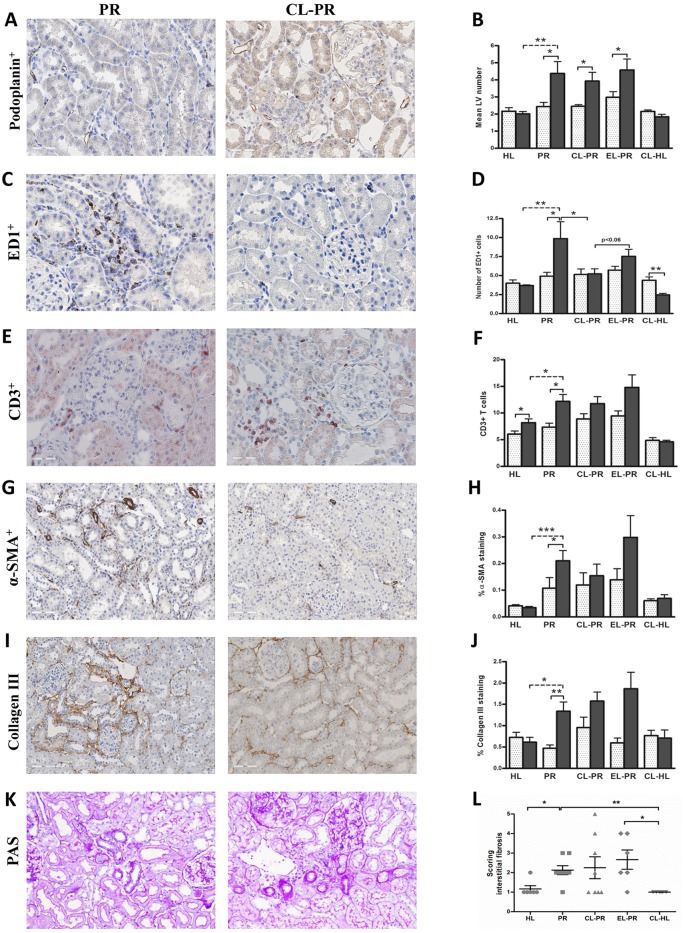
Effects of macrophages depletion by CLs on renal lymphangiogenesis, inflammation and fibrosis. Quantification of immunohistochemical stainings of the kidneys of CL-treated proteinuric rats did not prevent the increase in LV number in proteinuric rats (A,B) despite completely blocking macrophage influx at week 12 (C,D). However, this treatment had no obvious effect on T-cell influx (E,F), and did not have a significant effect on α-SMA (G,H) or collagen III deposition (I,J). In the same line, the development of interstitial fibrosis was also not inhibited by CL intervention (K,L). White dotted bars represent week 6 before treatment; black bars represent week 12 after treatment. The PAS staining quantification (interstitial fibrosis) is shown at 12 weeks. HL, healthy; PR, proteinuric untreated; CL, clodronate liposome; EL, empty liposomes. *P<0.05, **P<0.01, ***P<0.001.